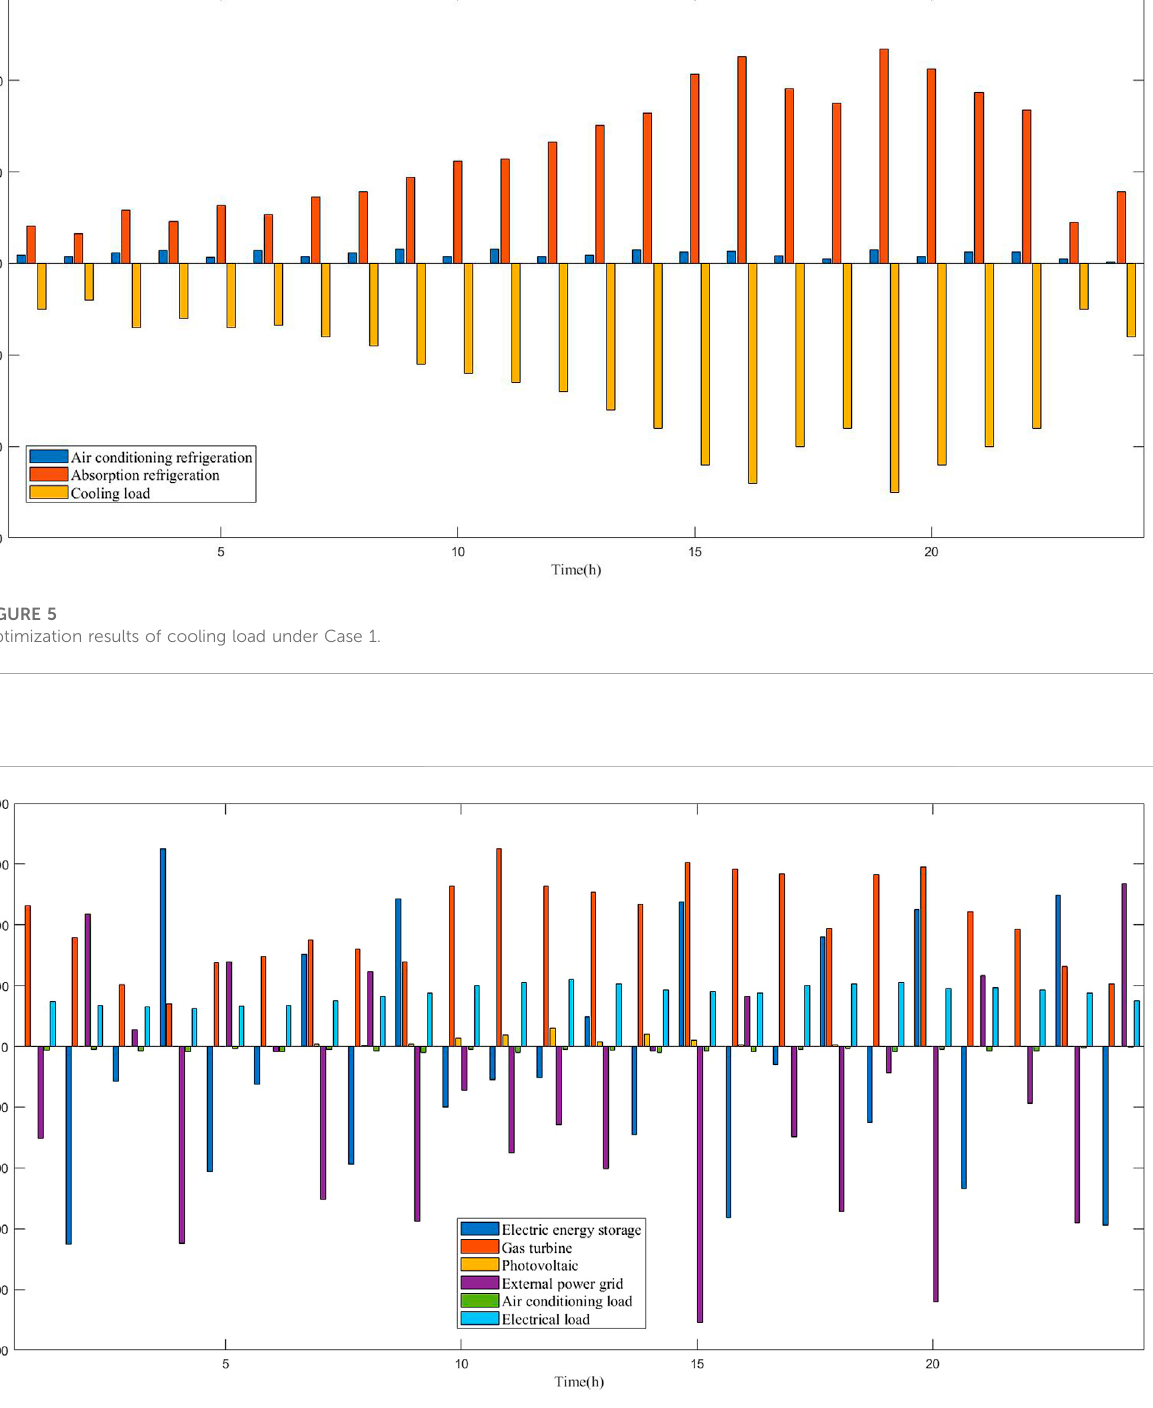
FIGURE 6 Optimization results of power load under Case